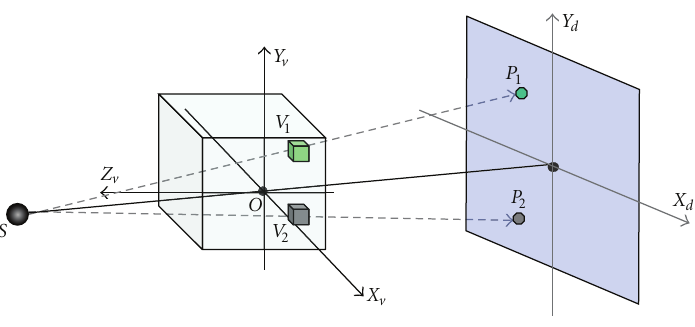
Figure 5: The vertical symmetry in circular cone-beam projection